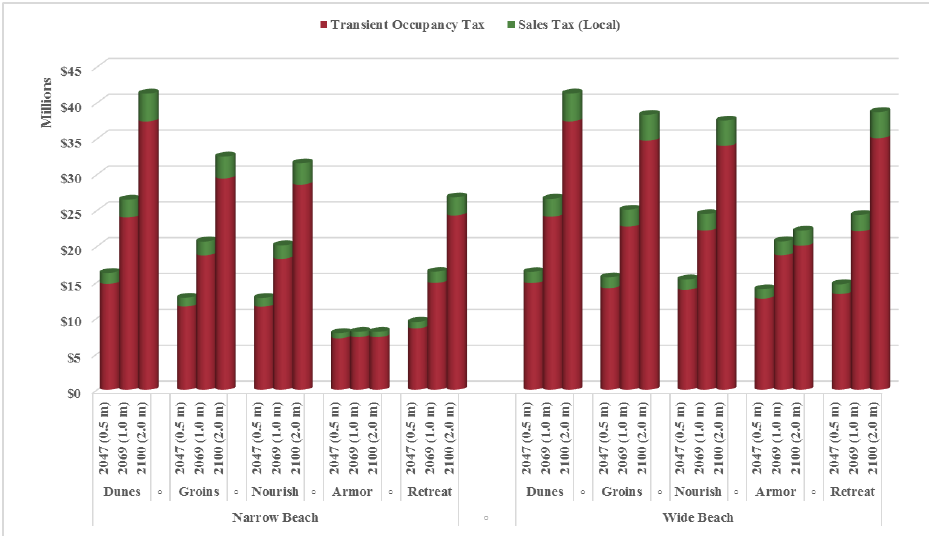
Figure 14. Estimated (local) sales tax and transient occupancy tax revenues for different scenarios.